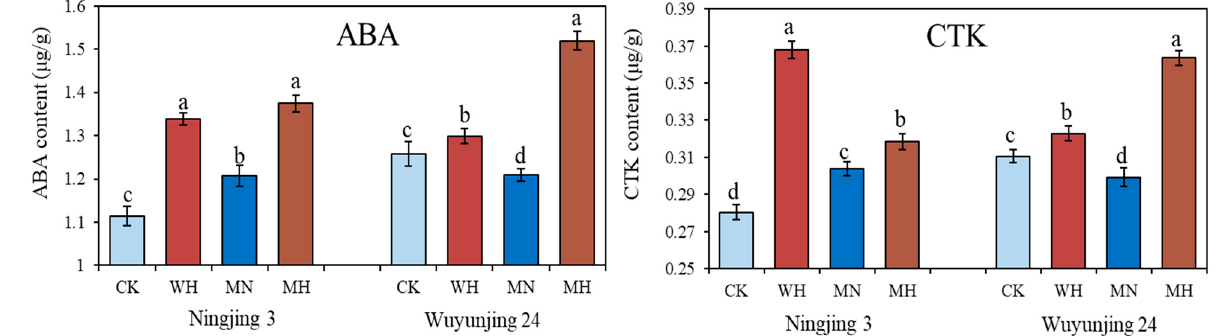
Figure 6. Effects of exogenous MeJA on the content of CTK and ABA of rice leaves at the booting stage under high temperatures. Note: CK: natural temperature and sprayed with water; MN: natural temperature and sprayed with MeJA; WH: heat stress and sprayed with water; MH: high temperature and sprayed with MeJA. ABA: abscisic acid; CTK: cytokinin. Bars are the standard deviation. Values followed by different letters are significantly different at 5% probability level.